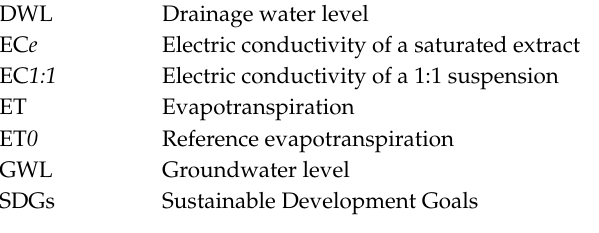
Table S1: Estimation of groundwater seepage from the field to the open drainage (W g3 ), Figure S1: Cotton yield in the experimental field,